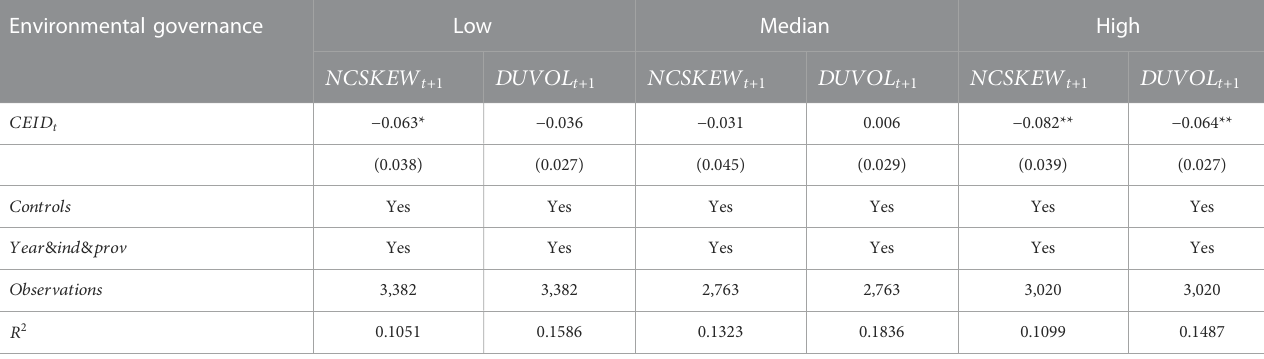
TABLE 11 Based on the perspective of government environmental governance. Environmental